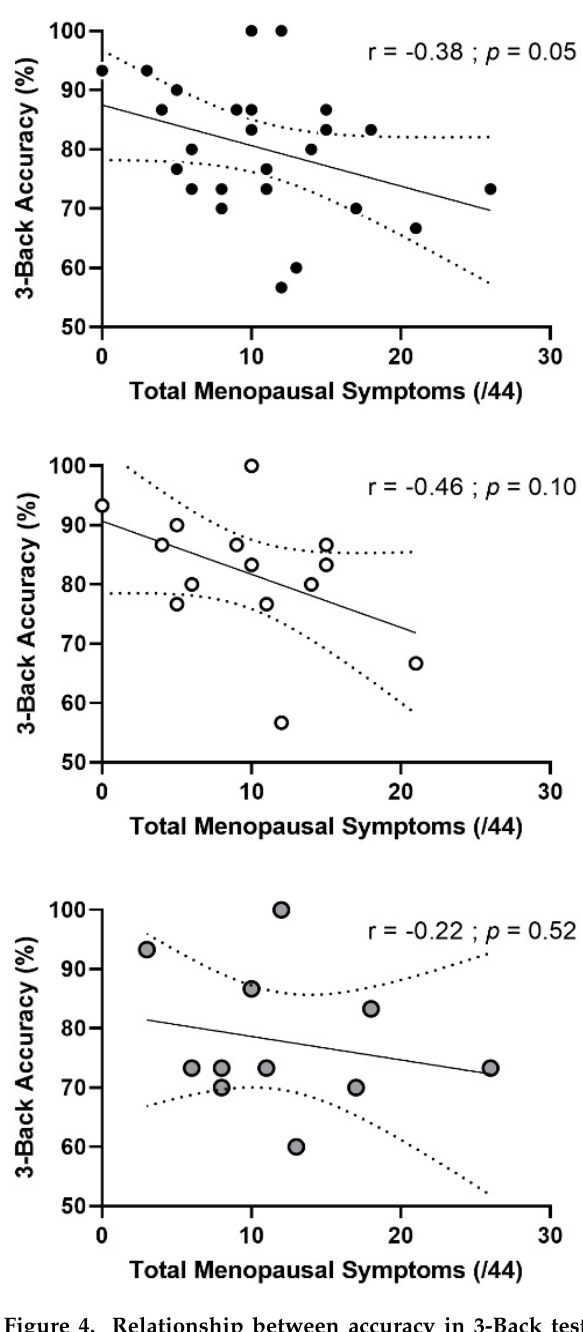
Figure 4. Relationship between accuracy in 3-Back test and total menopausal symptoms (top panels) in pre- and post-menopausal females . Top panel: pre-menopausal (n = 13) and post- menopausal (n = 10) females combined. Middle panel: pre-menopausal females only. Bottom panel: post-menopausal females only. The r and p values are for a Pearson correlation analysis.